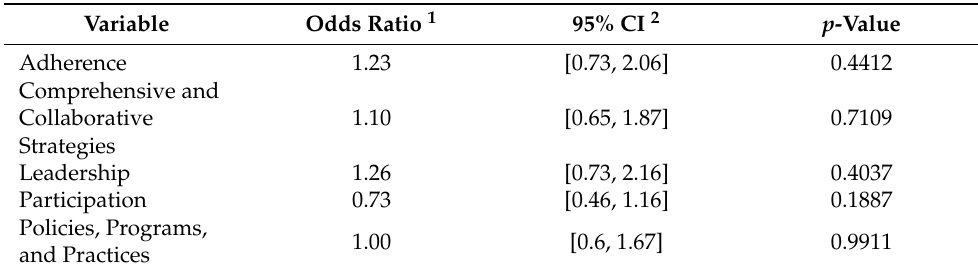
Table 4. Association between corporate nursing home ownership and being in the bottom 25% percentile of WISH domain.